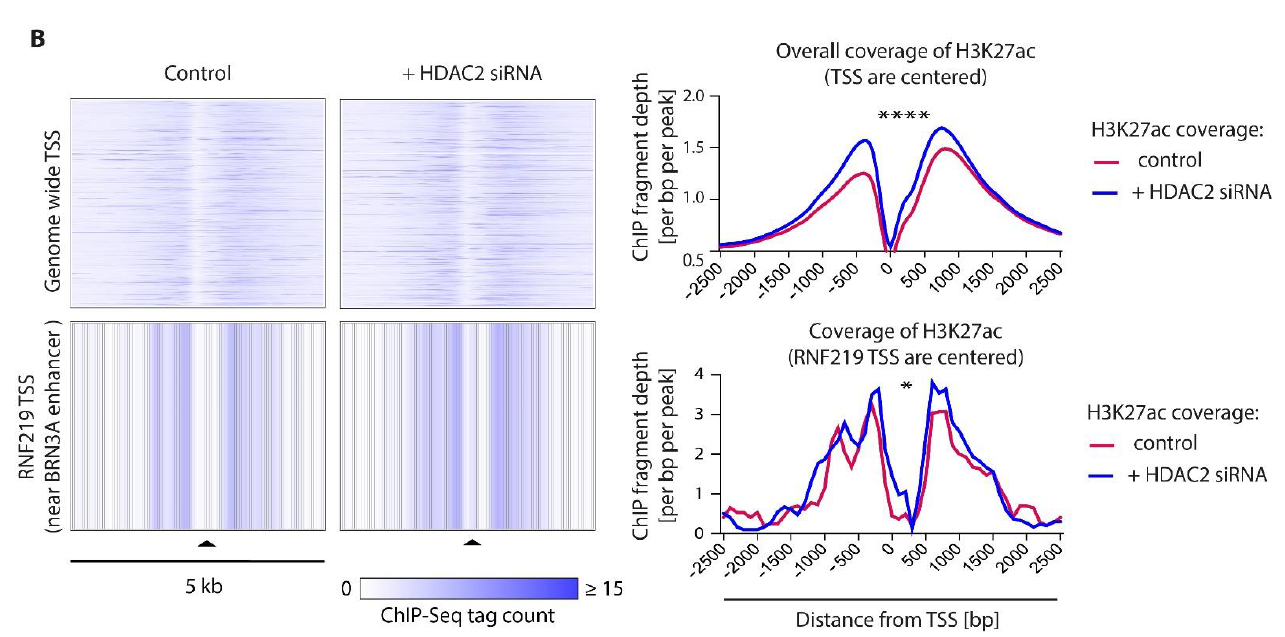
Figure 6. HDAC2 inhibition increases H3K27 acetylation (H3K27ac) status in a distal enhancer element of BRN3A . ( A ) H3K27 acetylation status of the genetic region chr13:78,550,000–78,700,000 (hg38) in WM9 melanoma cells transfected with HDAC2-specific siRNA or control siRNA (control) compared to input. Peaks illustrate the normalized read counts. Blue bars highlight identified peaks with a false discovery rate of 1 × 10 −6 compared to input in the genomic region chr13:78,656,679 – 78,661,679, which is located near to the TSS of the RNF219 gene and annotated as a promoter/enhancer element of BRN3A in the GeneHancer database (GeneHancer Identifier GH13J078657, https://www.genecards.org/cgi-bin/carddisp.pl?gene=POU4F1, accessed on 18 September 2019 [37]). ( B ) Heat maps and histograms of ChIP-Seq tag counts of the H3K27ac status in a 5 kb wide range around overall TSS and the RNF219 TSS. Profiles show a significant increase of H3K27ac rate around global (****: p = 0.0001; Wilcoxon test, paired, two-sided) and the RNF219 TSS (*: p = 0.0156; Wilcoxon test, paired, two-sided), representing the BRN3A enhancer element